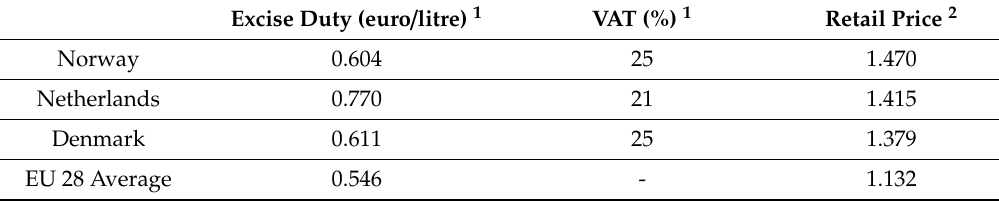
Table 4. Fossil transport fuel taxes (unleaded petrol, January